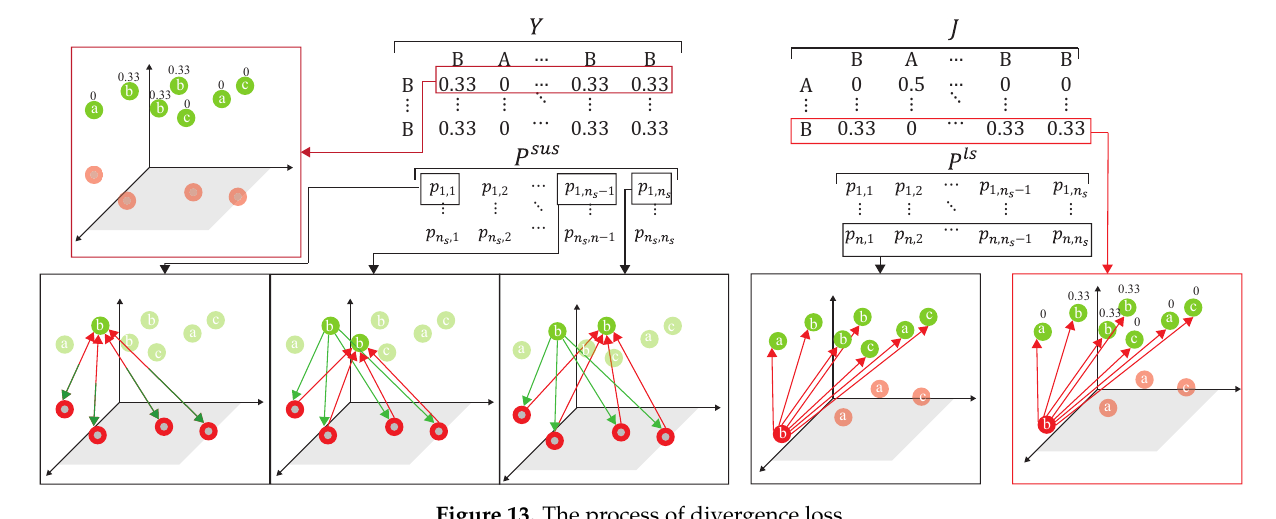
Figure 13. The process of divergence loss.